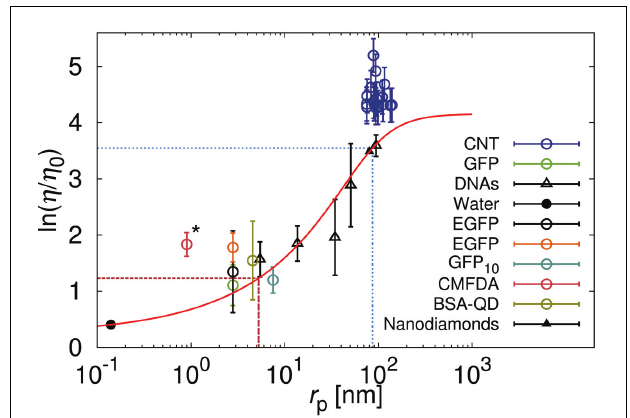
FIGURE 2 | Diffusion coefficient as a function of the probe’s hydrodynamic radius, r p , in aqueous solution of the flexible polymer polyethylene glycol, and of the micelles formed of non-ionic surfactant C 12 E 6 . The c / c ∗ ratio (concentration divided by the overlap concentration) for both systems was set the same and equal to 14.67, and corresponded to the concentrations of 14 and 37.5% for surfactant and for polymer, respectively. Curves were generated using Equation (2) with parameters: a = 0 . 62, b = 2 . 42 for polymer solutions, and a = 0 . 87, b = 0 . 9 for surfactant solutions; for details see [14]. to the hydrodynamic radius of the actin filaments in the cyto- HeLa ξ ≈ 5 [14].